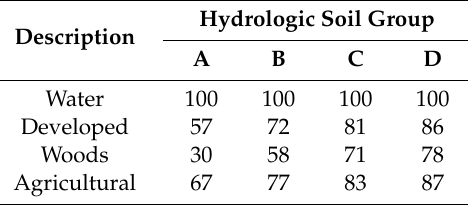
Table A2. Curve numbers used for reclassified land covers.